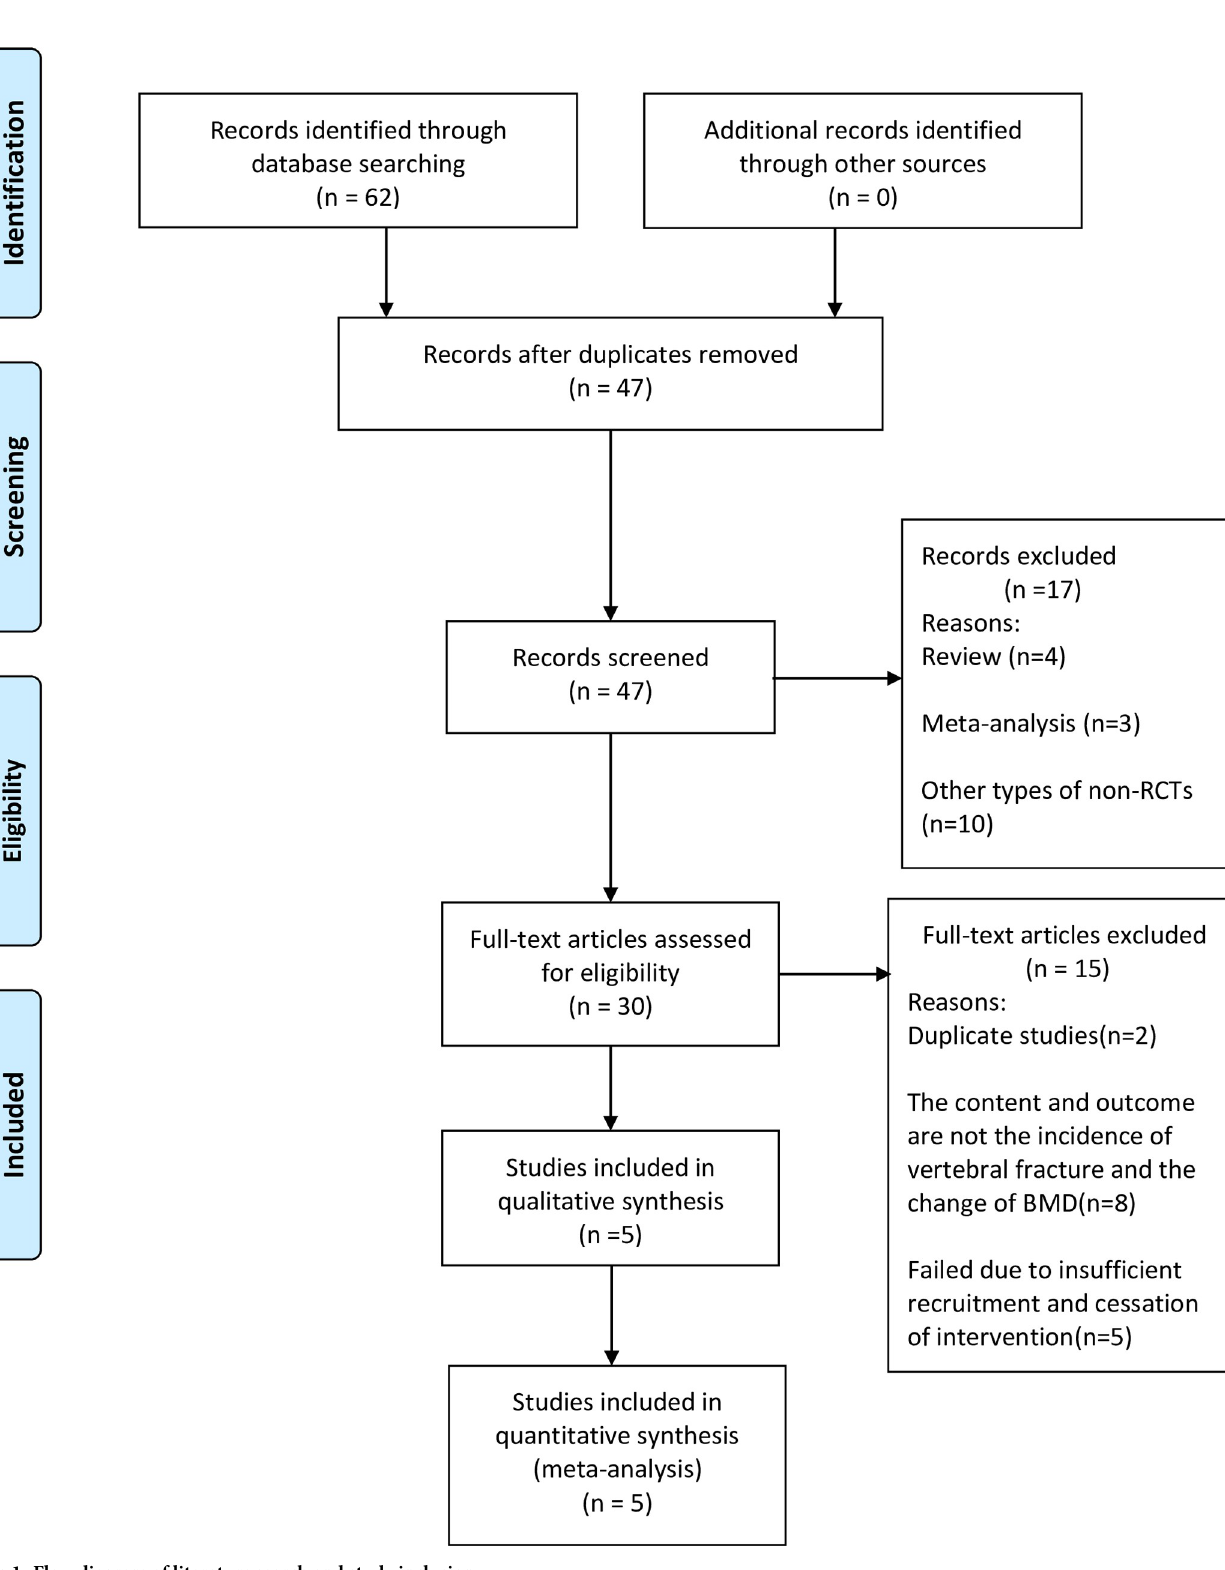
PLOS ONE | https://doi.org/10.1371/journal.pone.0267706 May 31,